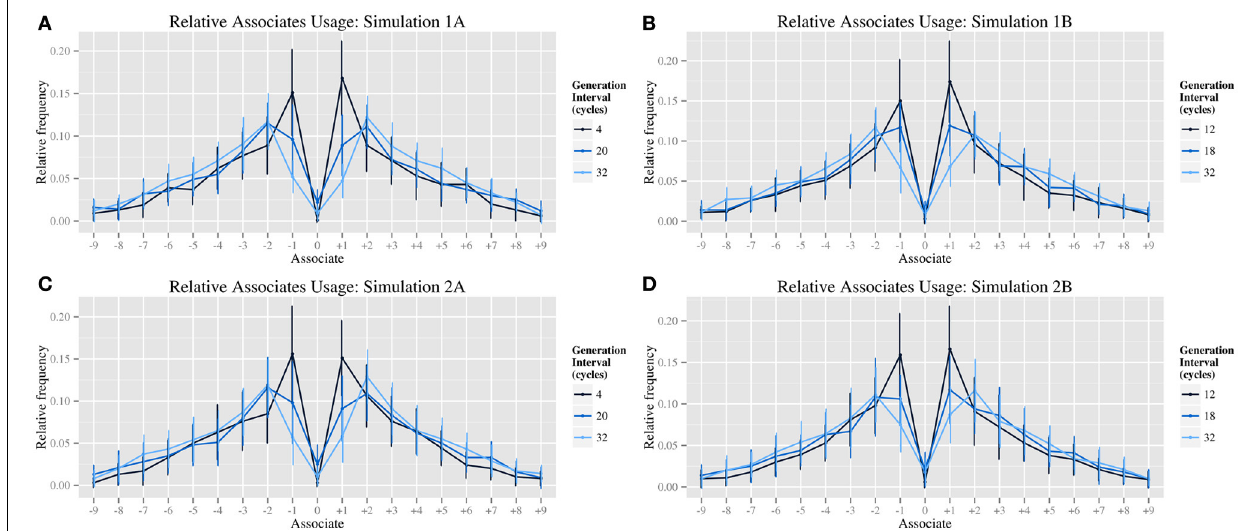
FIGURE 3 | Graphs of specific biases at varied generation rates; relative associates usage for simulations 1A (A), 1B (B), 2A (C), 2B (D).